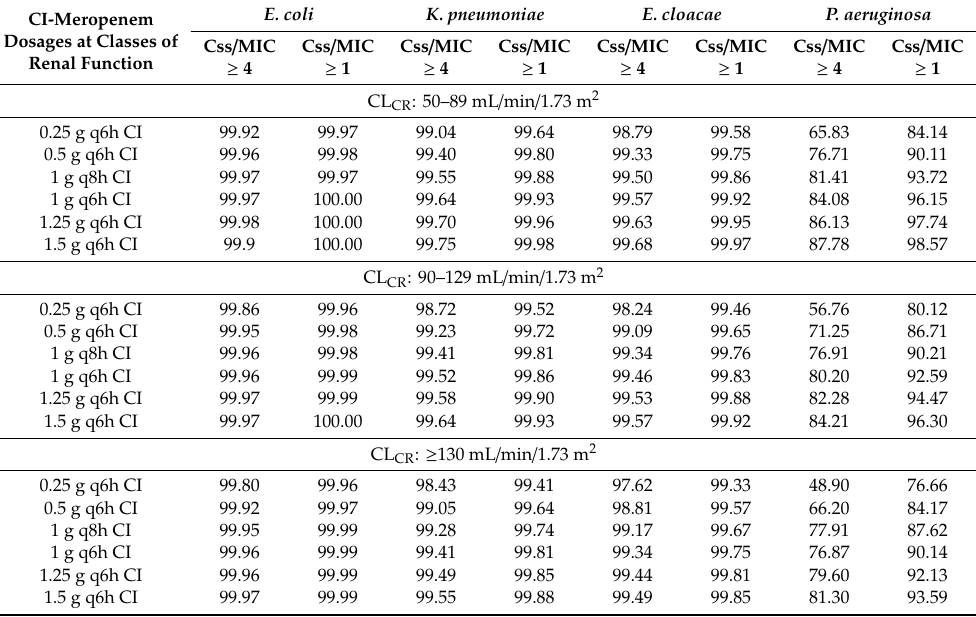
Table 3. Cumulative fraction of response (CFR) achievable at Css / MIC of ≥ 4 and ≥ 1 against the EUCAST MIC distributions of E. coli , K. pneumoniae , E. cloacae and P. aeruginosa with incremental dosages of CI meropenem in di ff erent classes of renal